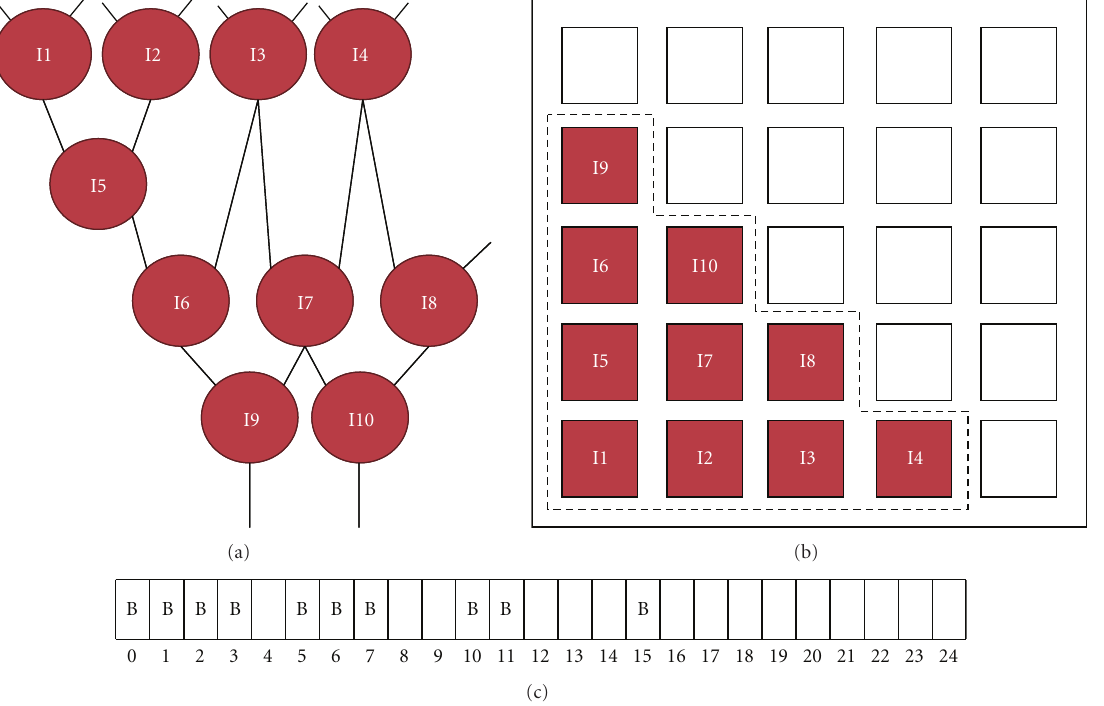
Figure 6: Defect-free resource allocation: (a) data dependency graph, (b) FAT-array resource allocation based on data dependency, and (c) allocated units set as busy in resource